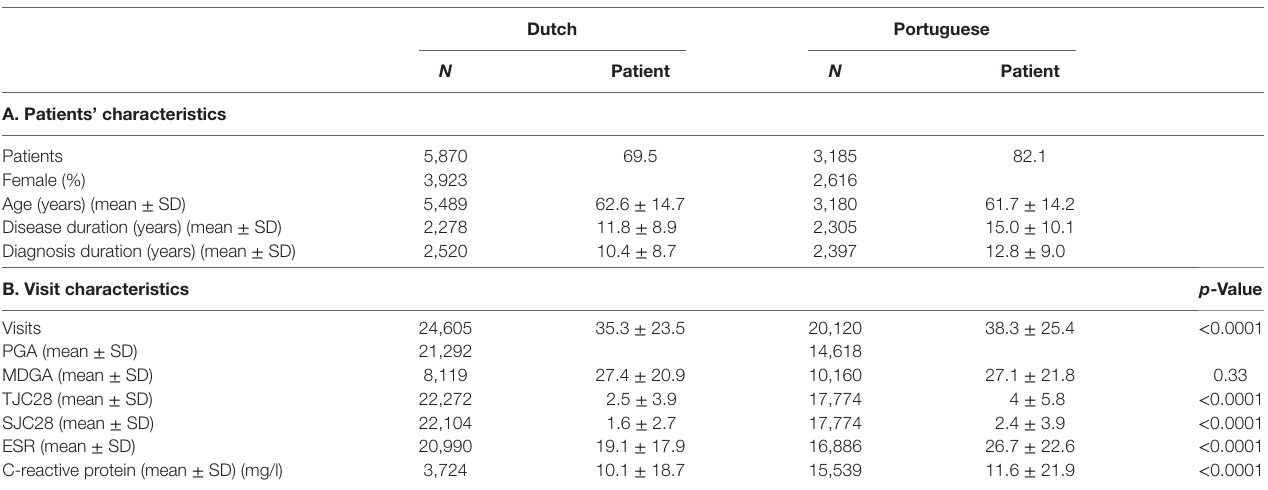
TaBle 2 | Characteristics of patients and their